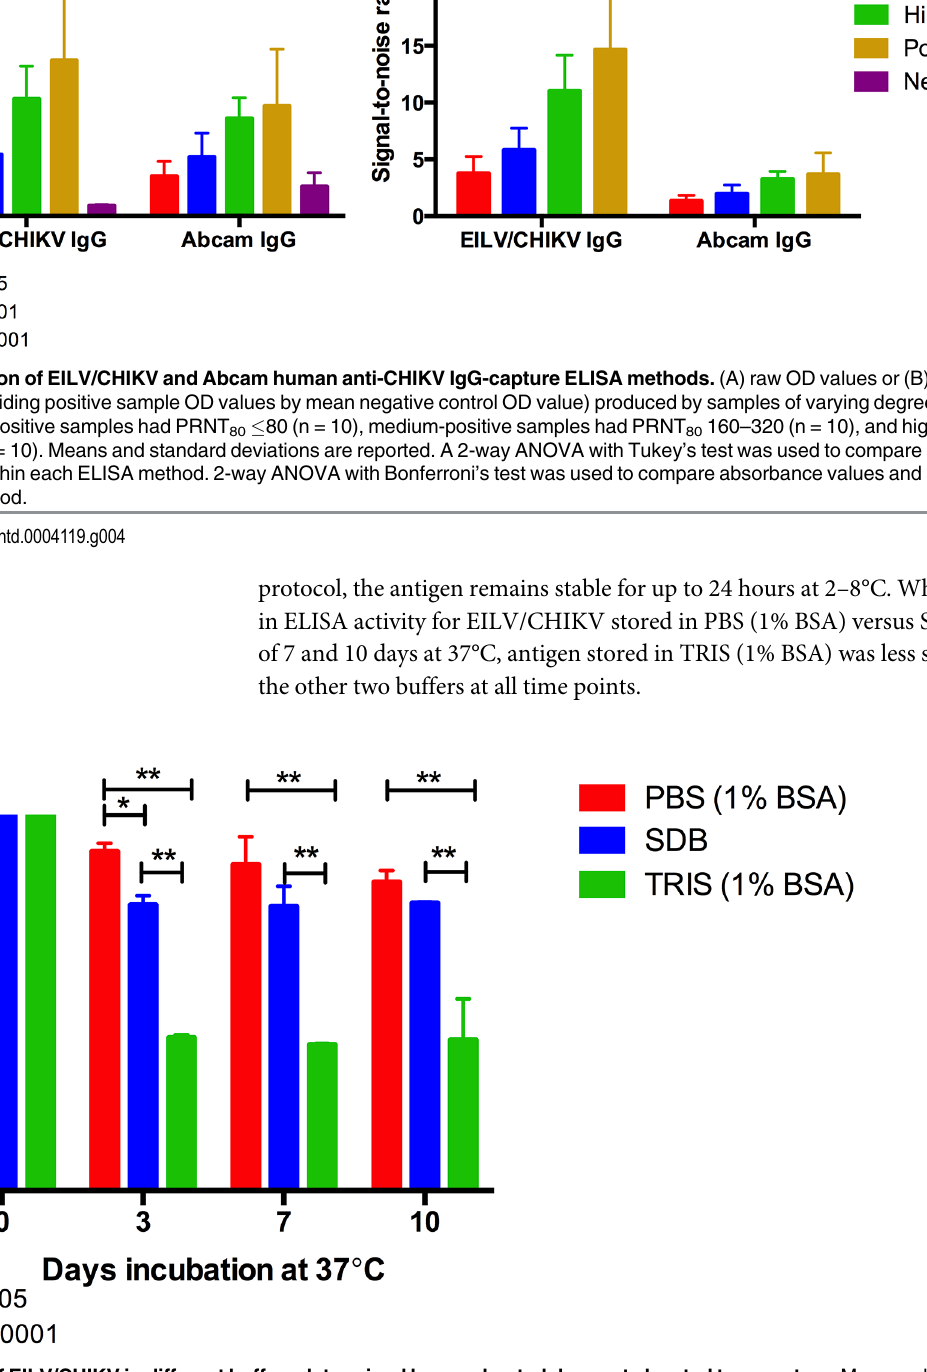
Fig 5. Stability of EILV/CHIKV in different buffers determined by accelerated decay at elevated temperature. Mean and standard deviations of three replicates are reported. A 2-way ANOVA with Tukey ’ s test was used to compare the effects of different buffer preparations on ELISA